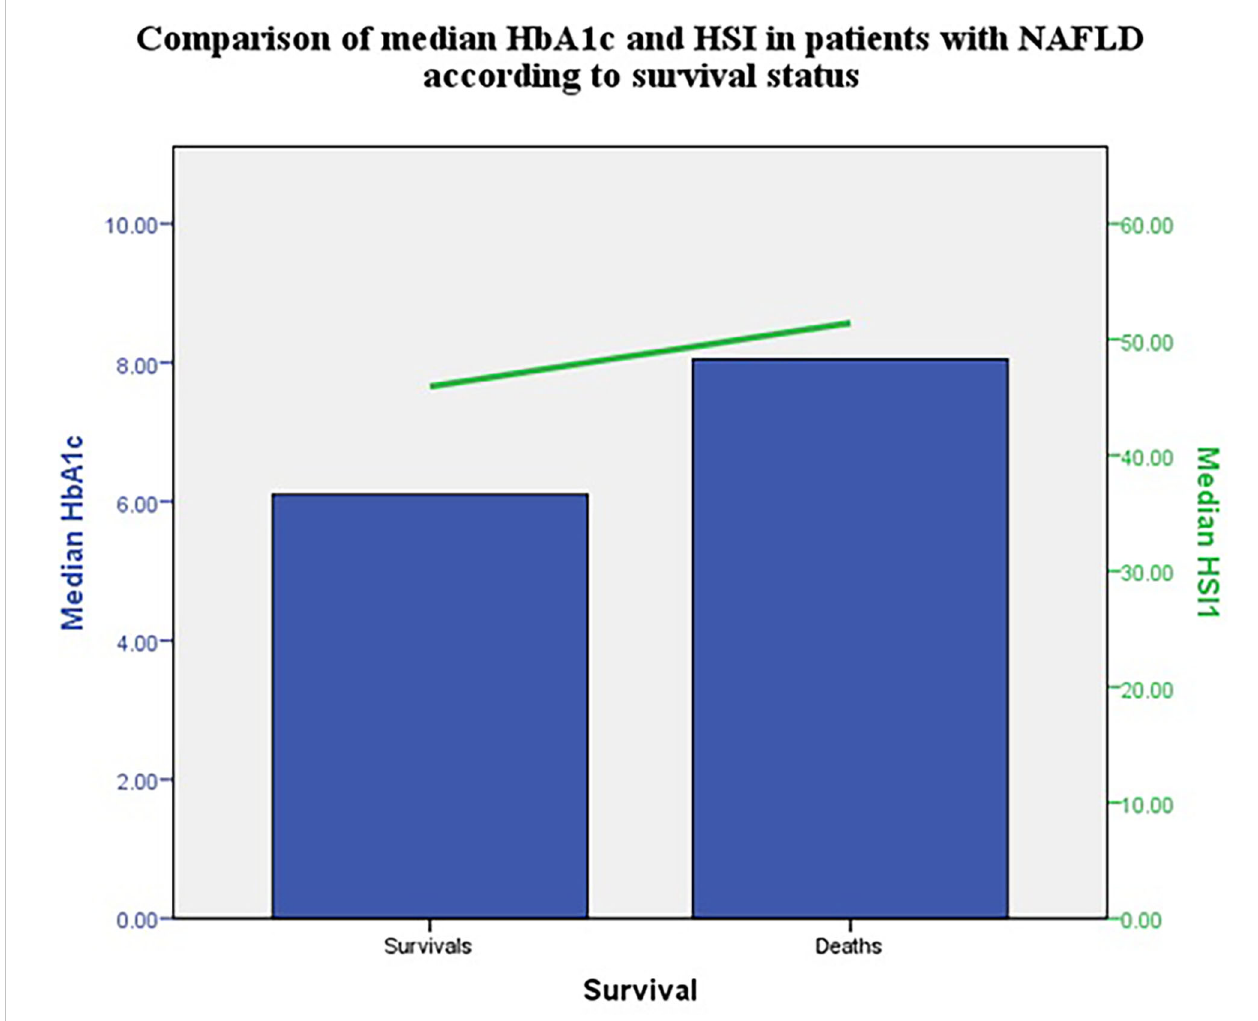
FIGURE 1 Comparison of median HbA1c and HIS in patients with NAFLD according to survival